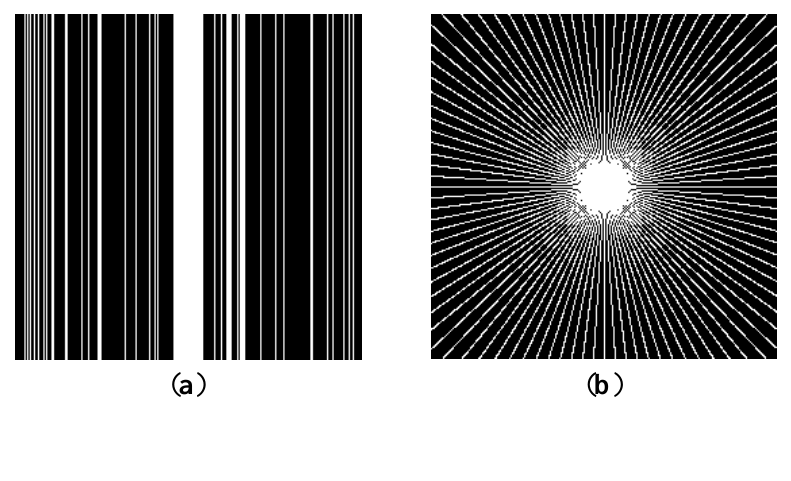
Figure 8. ( a ) VD Random Sampling, ( b ) Radial sampling